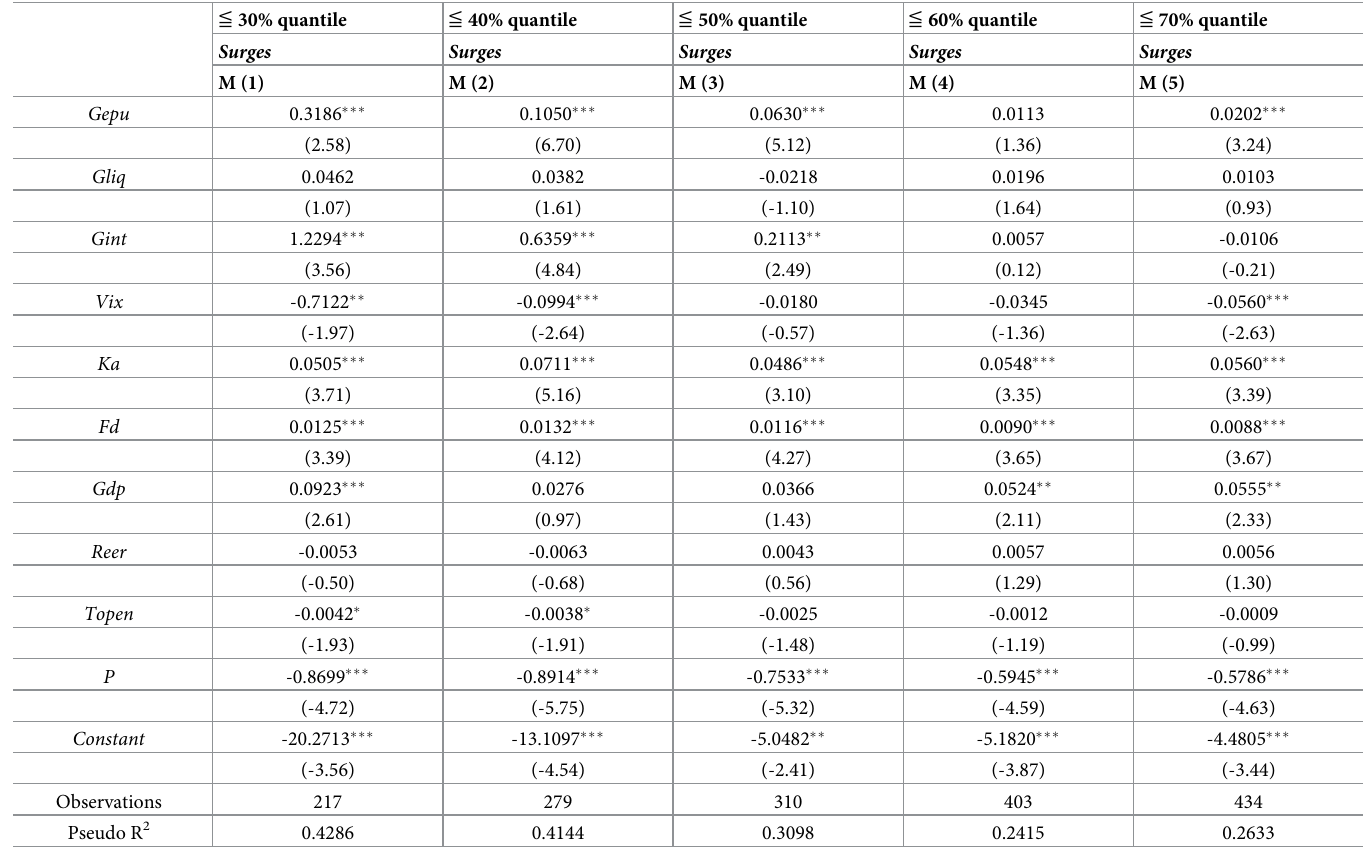
Table 11. Impact of the Gepu on surges to varying